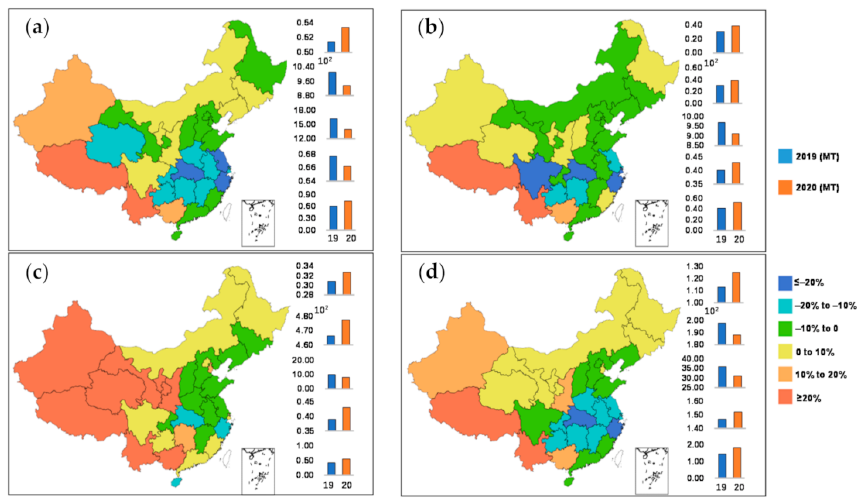
Figure 2. Changes in electricity-generation CO 2 emissions in Mainland China. ( a ) Total